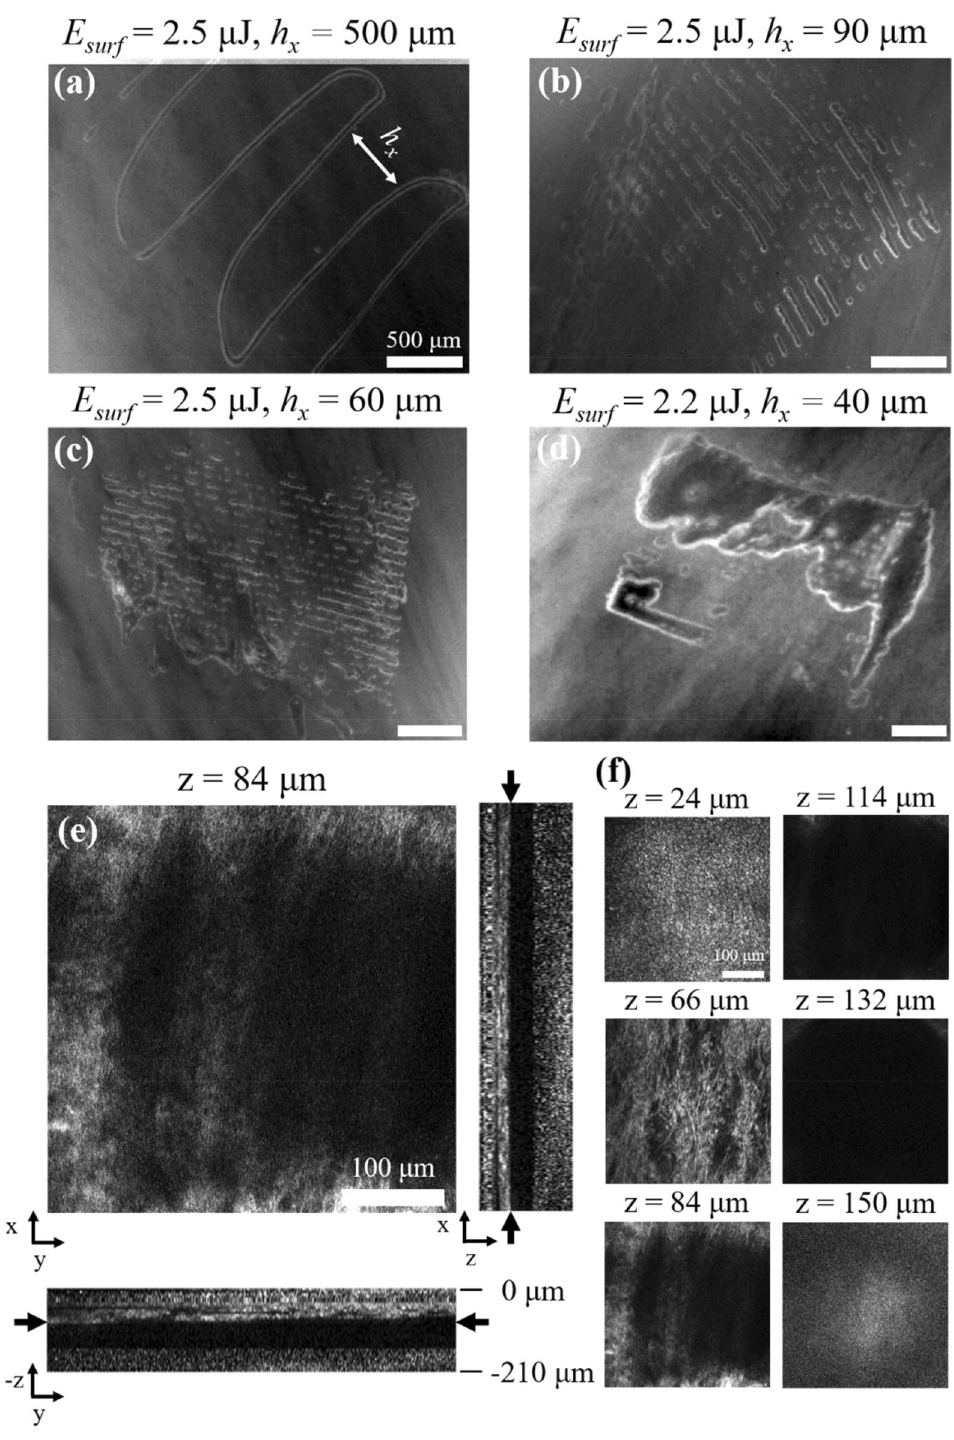
2.5 μJ, Figure 5. Tissue ablation performance of surgical probe. Sub-epithelial ablation with ( a ) E surf = 500 μm, ( b ) E 90 μm, ( c ) E 60 μm, and ( d ) E 2.5 μJ, h 2.5 μJ, h 2.2 μJ, h x x = x = surf = surf = surf = = 40 μm. Scale bars are 500 μm. ( e ) TPAF images of sub-epithelial void created with E 2.2 μJ, h x surf = = 40 μm. Center image shows the top of the void 84 μm deep into VF, well within the SLP. Cross sections h x = through the centerlines of the center image are shown below and to the right. Black arrows in cross section images indicate the imaging plane shown in center image. ( f ) Montage of selected frames from the z-stack. Epithelial cells are visible up to a depth of 60 μm and collagen fibers are visible at deeper depths. The void is centered at 114 μm and extends ± 30 μm. Scale bars are 100